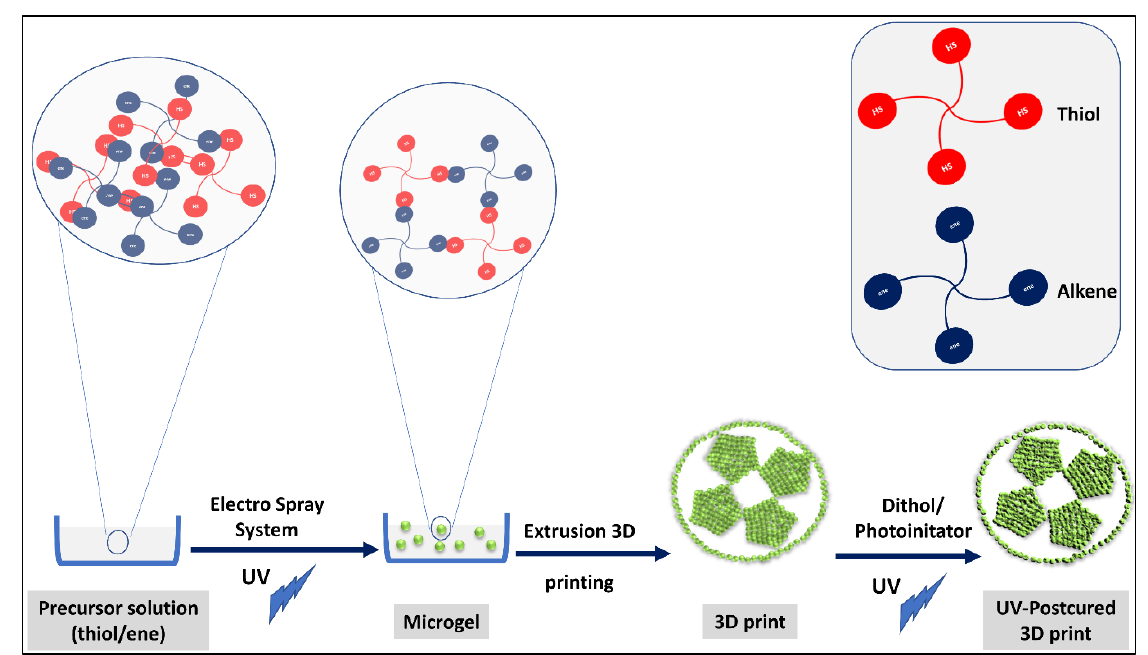
Figure 6. Clickable PEG hydrogel microspheres as building blocks for 3D bioprinting. The illustration is based on the work conducted by [17].